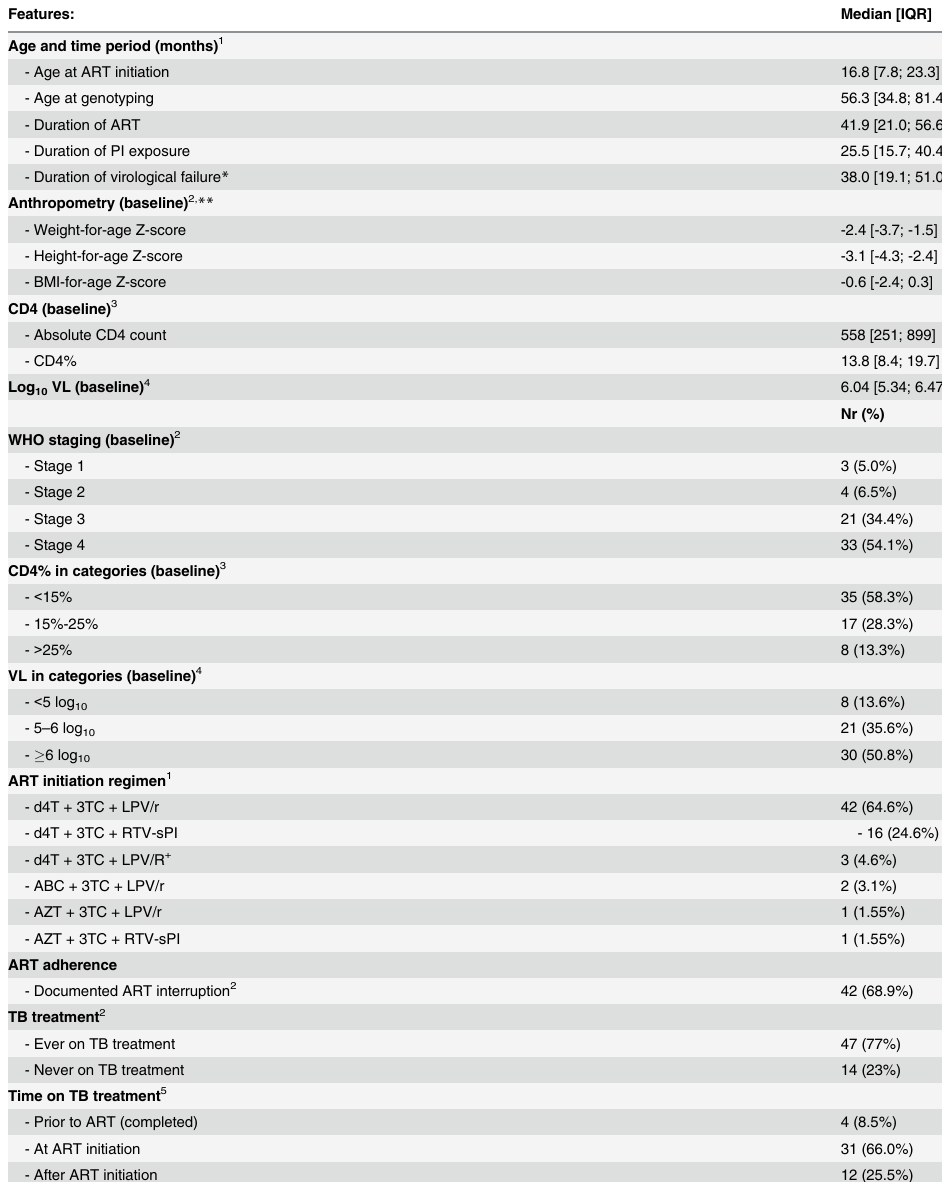
Table 1. Clinical and laboratory findings of the